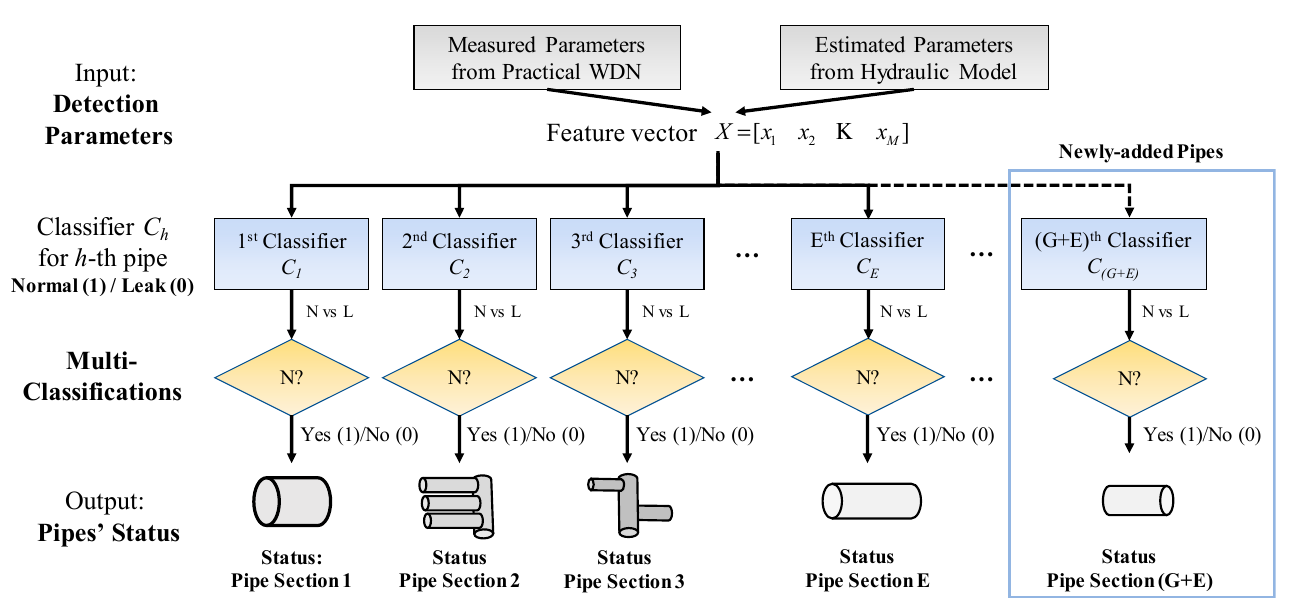
Figure 2. The parallel detection structure of MC-MLI.